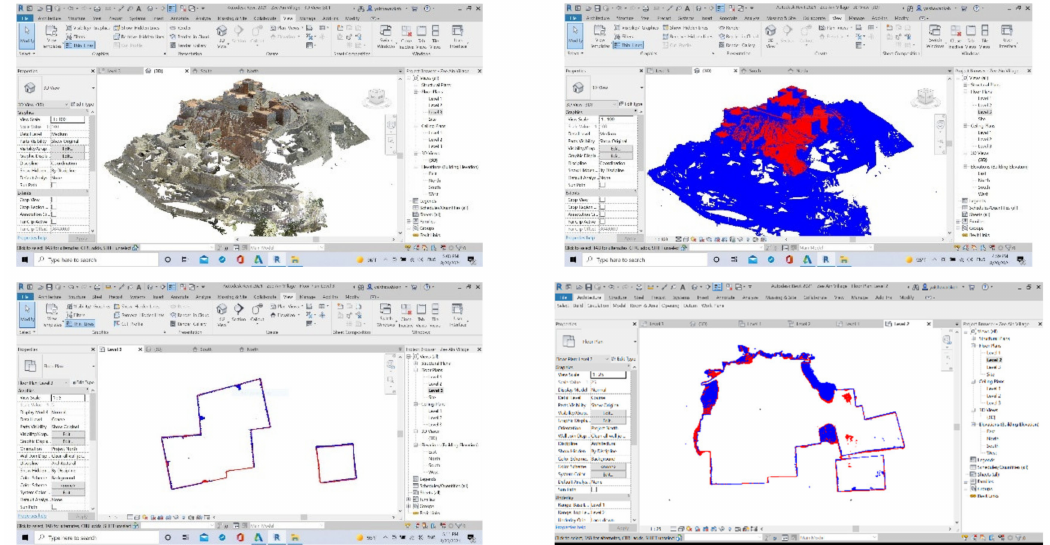
Figure 15. Import the integrated point cloud to enhance the digitization of the geometry for HBIM; TLS (Blue); UAV (Red).